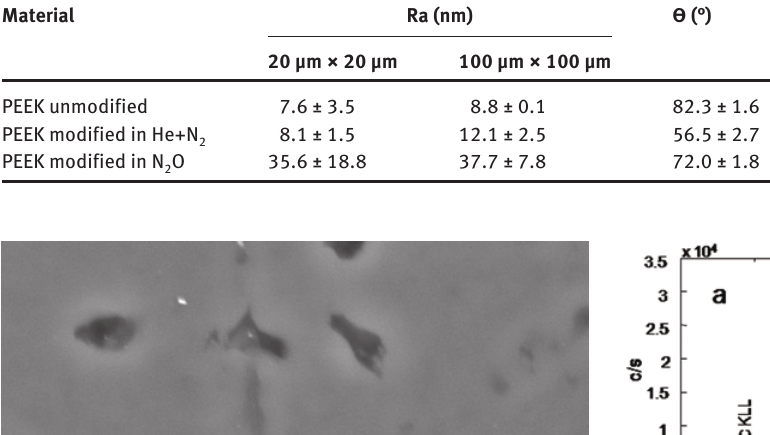
Table 2: Average surface roughness (Ra), water contact angle (Θ), dispersive part (γ d ), polar part (γ p ) of total surface free energy (γ t ) of PEEK without and after PECVD modification Material